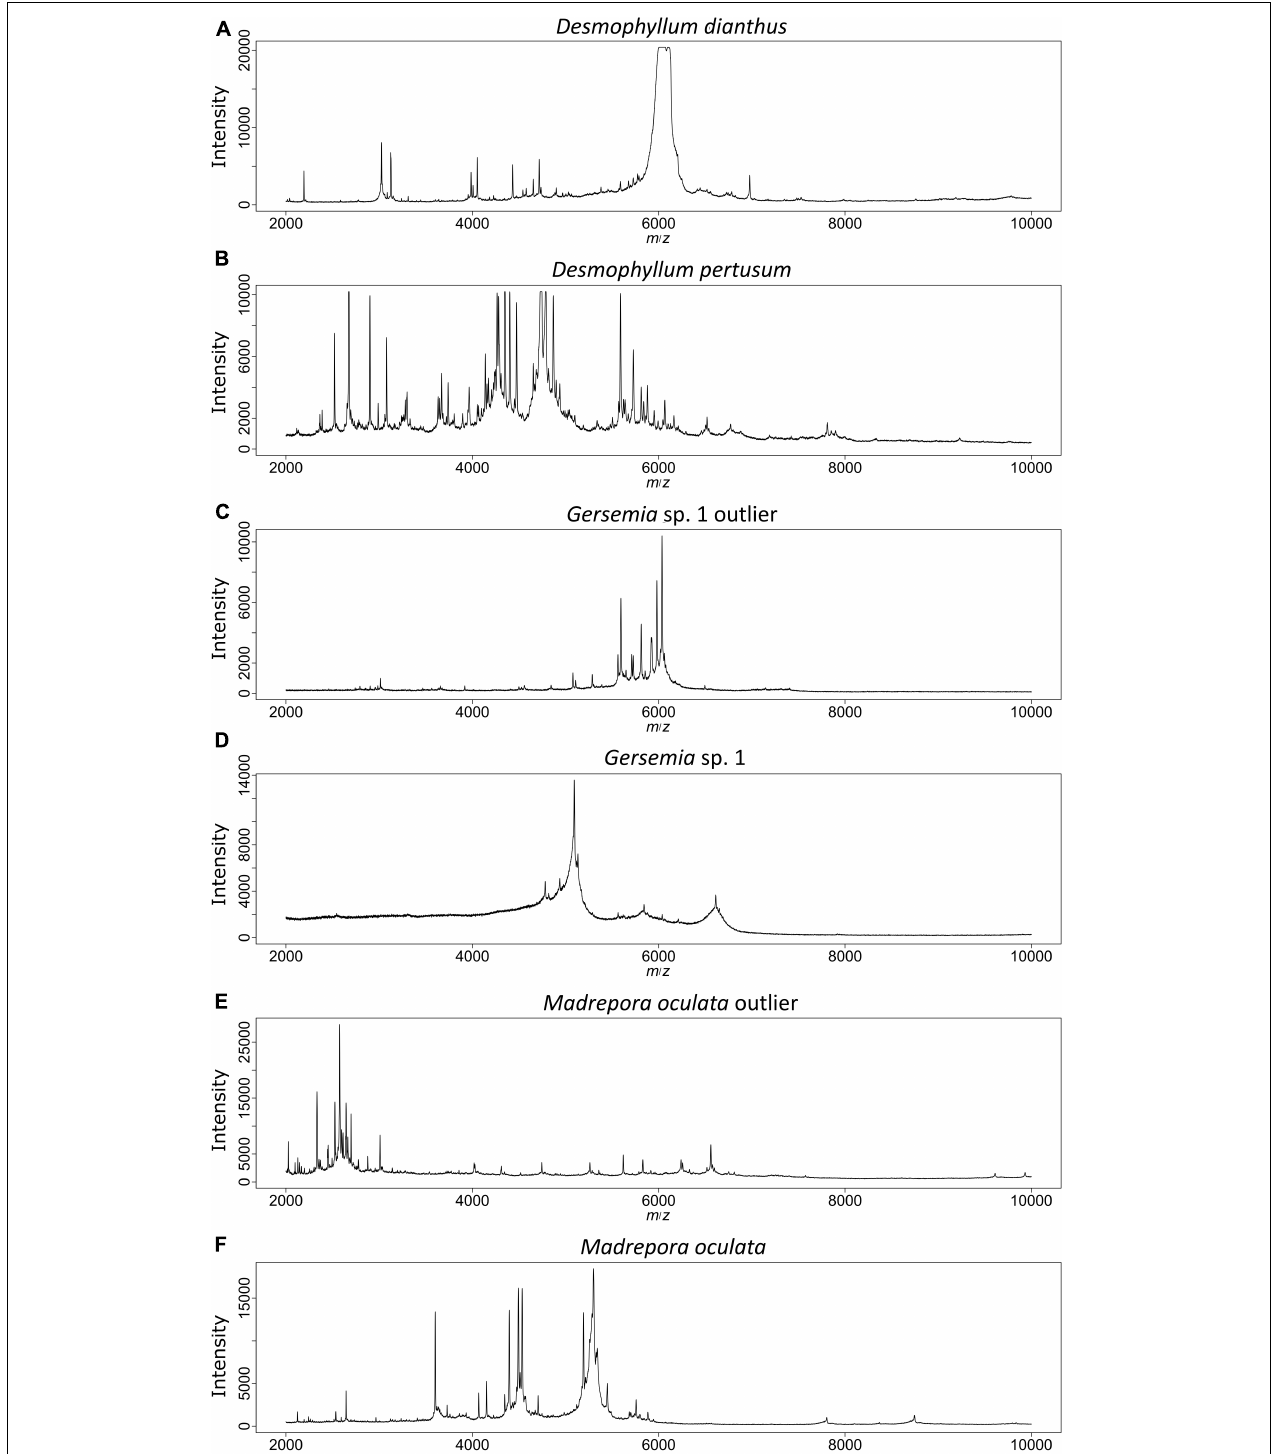
FIGURE 6 | MALDI-TOF mass spectra for selected specimens. Panels (A,B) were obtained from the different Desmophyllum species emphasizing clear differences between species. Panels (C,D) are derived from Gersemia sp. 1 and panels (E,F) from M. oculata. For these species, outliers were detected (C,E) , which compared to the remaining conspecifics (D,F) , show higher quality signals. This probably caused problems in clustering and occasionally in RF models.